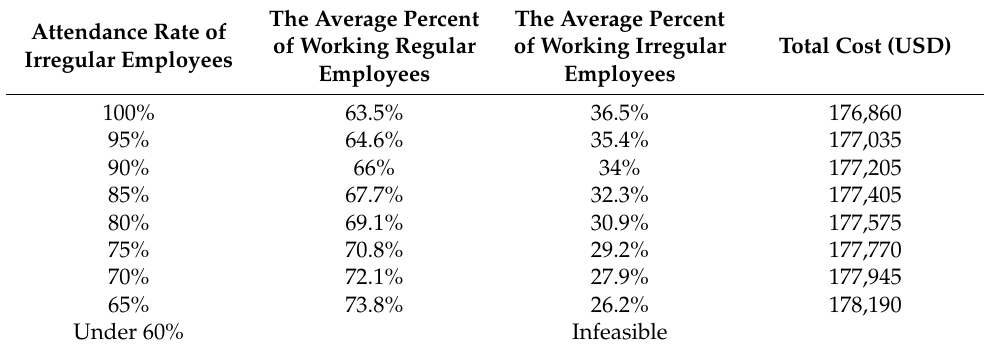
Table 7. Changes in the percent of regular and irregular employees and total cost.